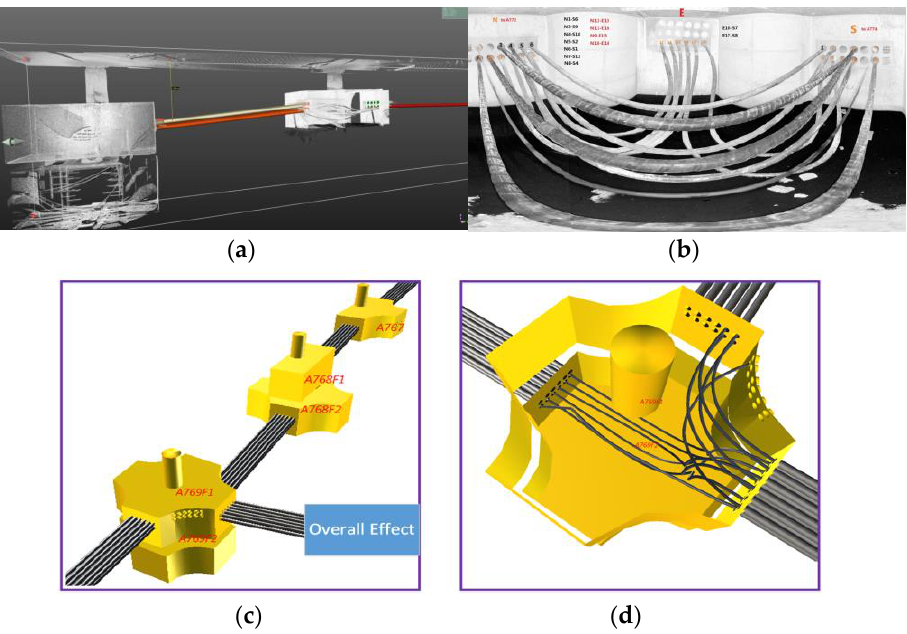
Figure 15. Overall modeling effect. ( a ) Overall original point cloud and pipe connections, ( b ) original point cloud internal image, ( c ) overall model and connections between models, and ( d ) internal cable model generation.